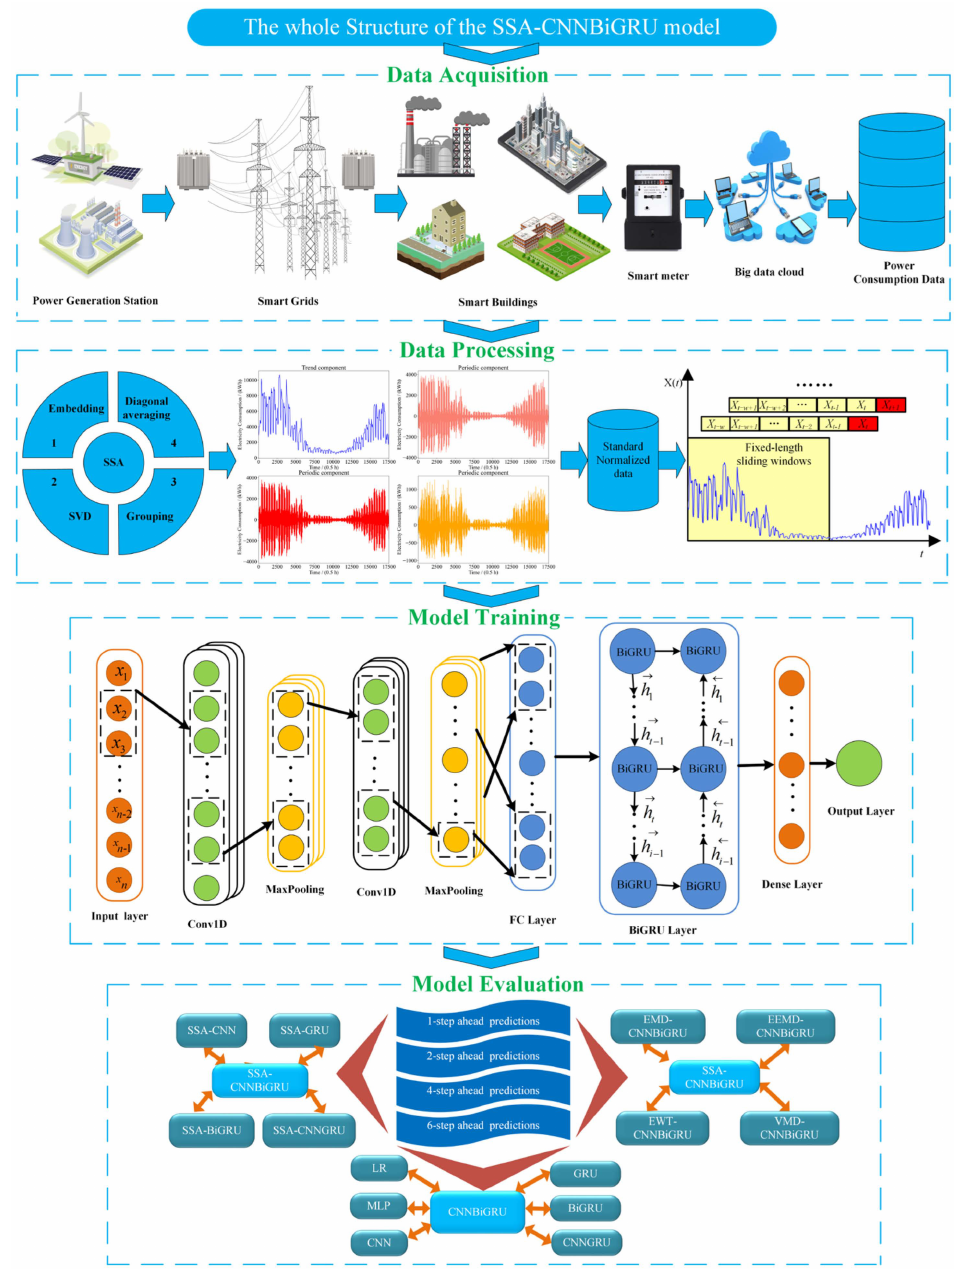
Figure 4. The overall structure of the proposed SSA-CNNBiGRU